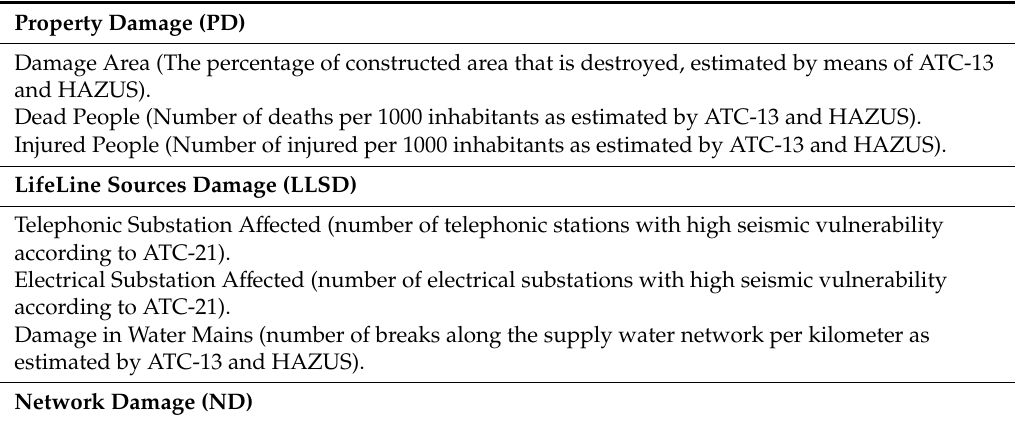
Table 1. Indicators used for the Physical Risk Fuzzy Model (References for ATC-13 / ATC-21 and HAZUS area [29,30],